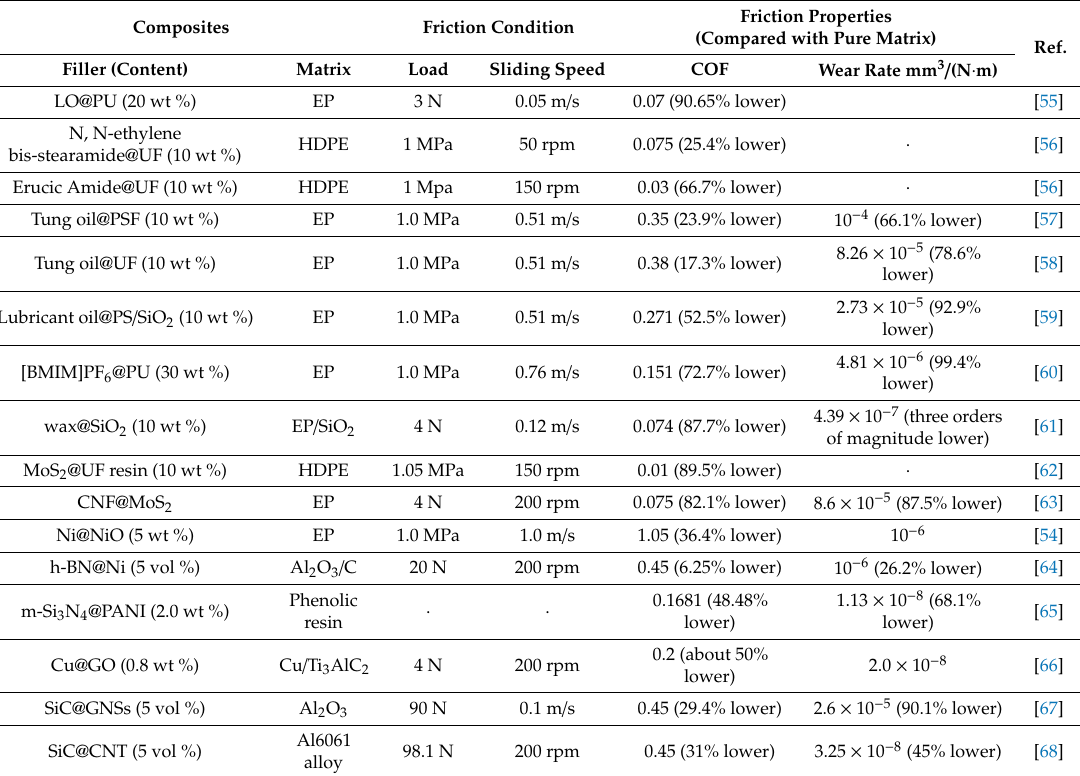
Table 2. Parameters of enhanced tribological properties.